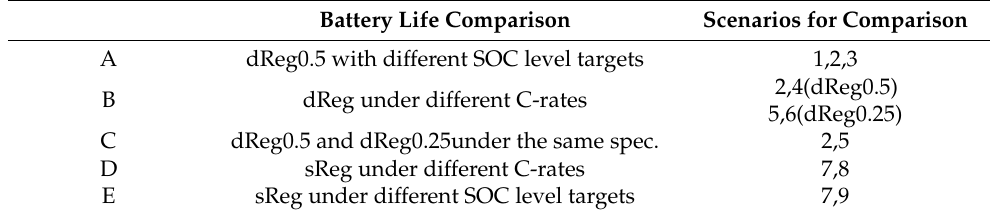
Table 3. Overview of comparison between scenarios.